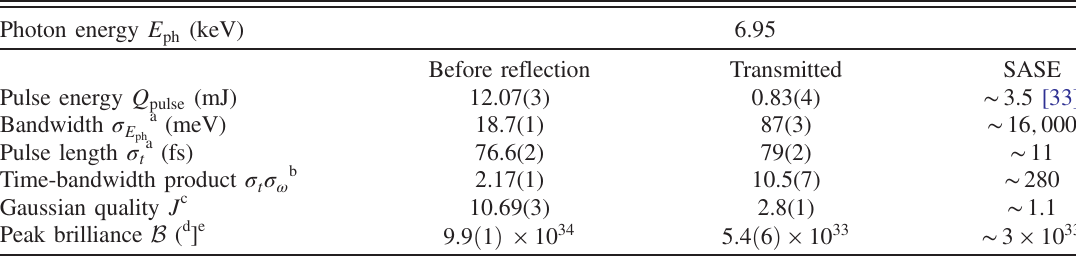
TABLE III. Main parameters of the resulting x-ray pulses in saturation. The errors denote the standard deviation of the shot-to-shot fluctuation in saturation as well as by averaging over 15 individual runs with equal base parameters. For comparison also SASE parameters for the 6.95 keV photon energy and the same electron distribution are appended. These are obtained by simulation (no taper) and scaling to measured